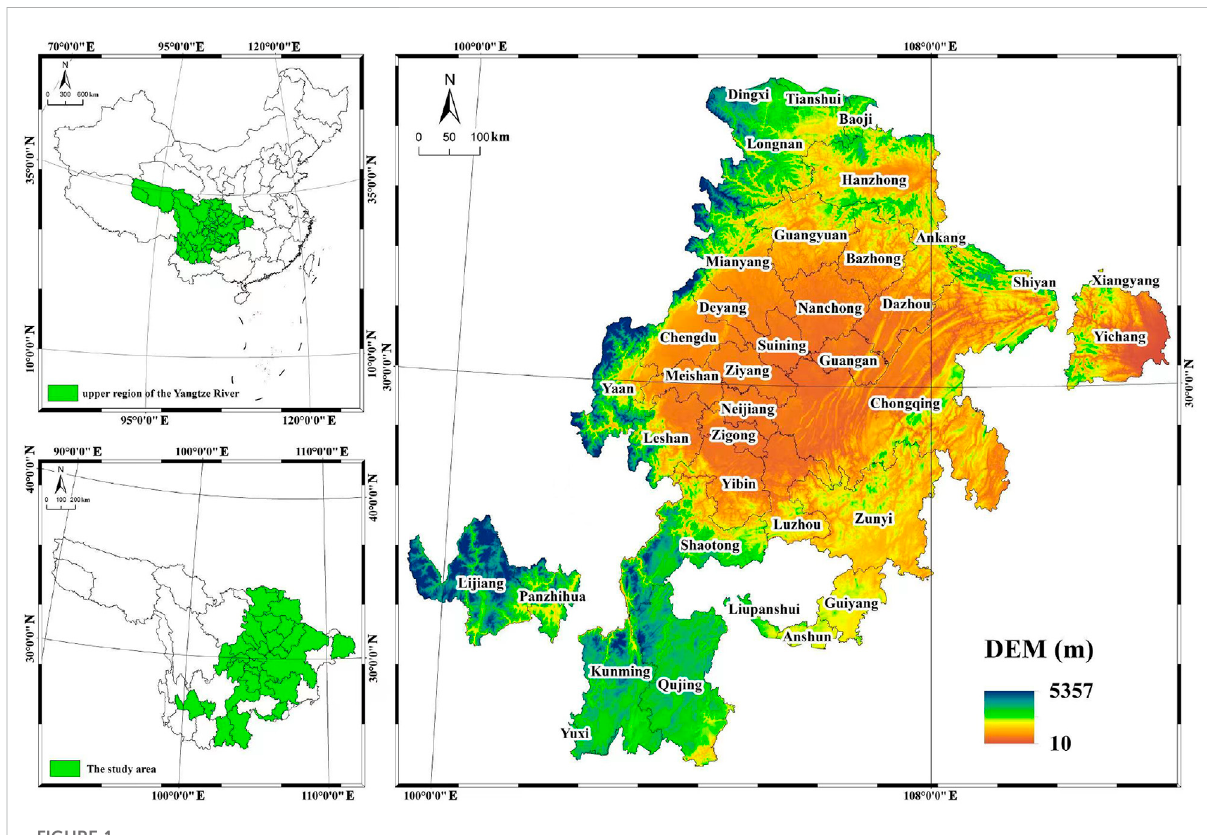
FIGURE 1 Upper Yangtze river basin and speci fi c study area